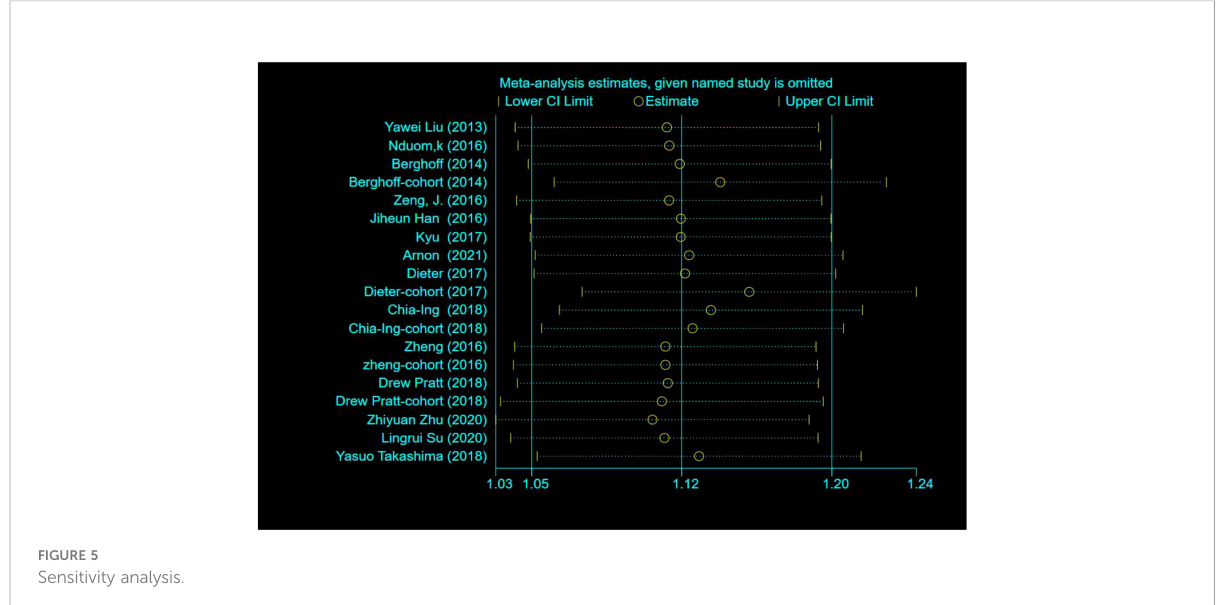
FIGURE 5 Sensitivity analysis.